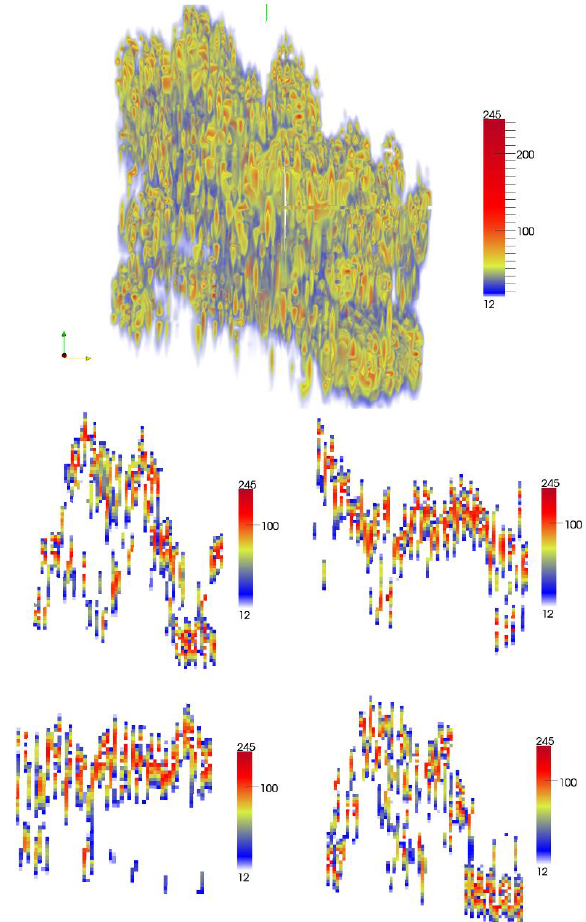
Figure 4. Top – 3D view of plot without ground returns – the scale reports the intensity in 8 bit scale. Bottom - four slices from the voxel grid reporting digitizer counts of